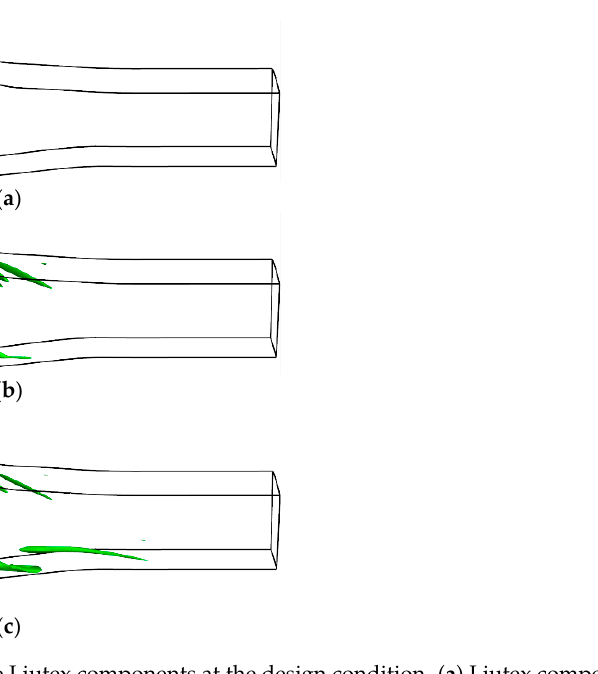
Figure 14. Iso − surface of the Liutex components at the design condition. ( a ) Liutex component in the x − axis. ( b ) Liutex component in the y − axis. ( c ) Liutex component in the z − axis.